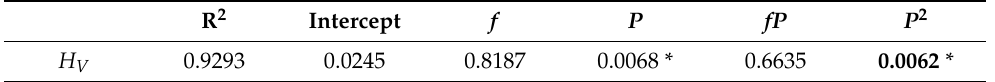
Table 10. R 2 value and p -value for individual structural elements of the regression model for H V . R